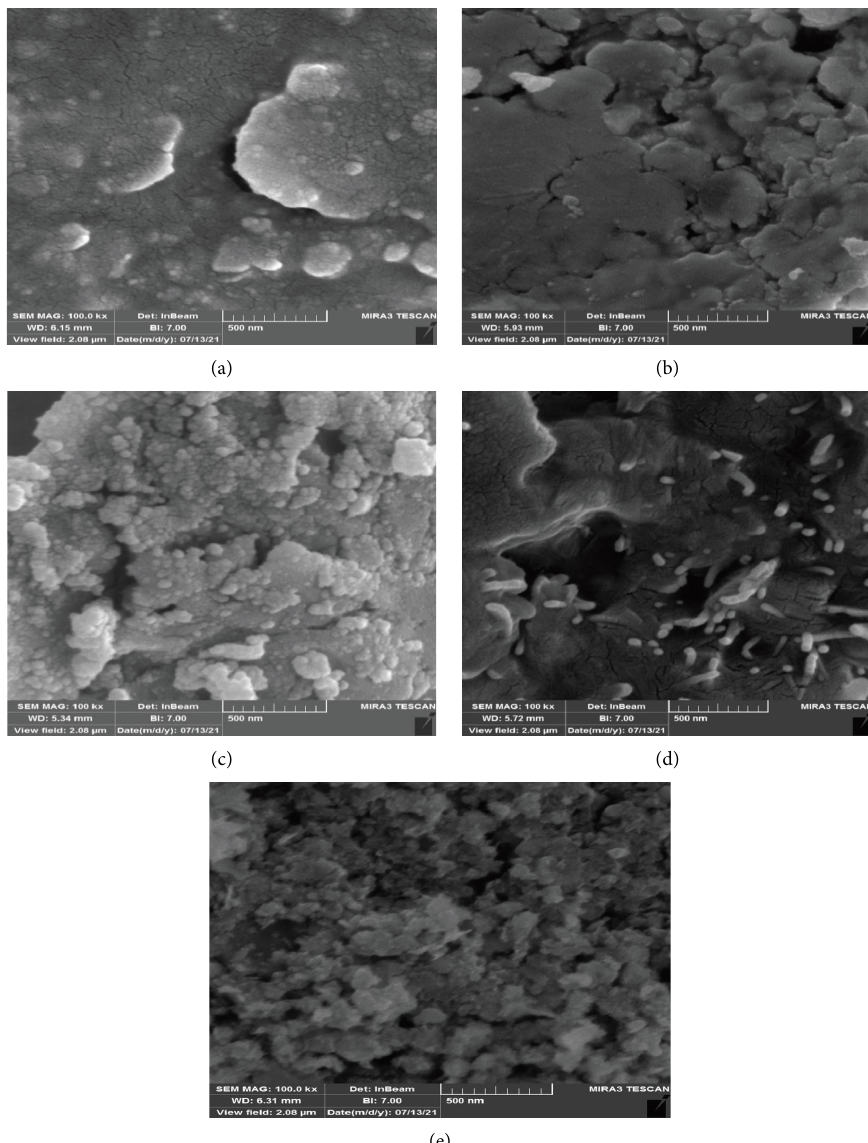
Figure 4: SEM images of flms. (a) CH, (b) CH-BCNF, (c) CH-BCNF-ZnO NPCs 0.5%, (d) CH-BCNF-ZnO NPCs 1%, and (e) CH-BCNF- ZnO NPCs